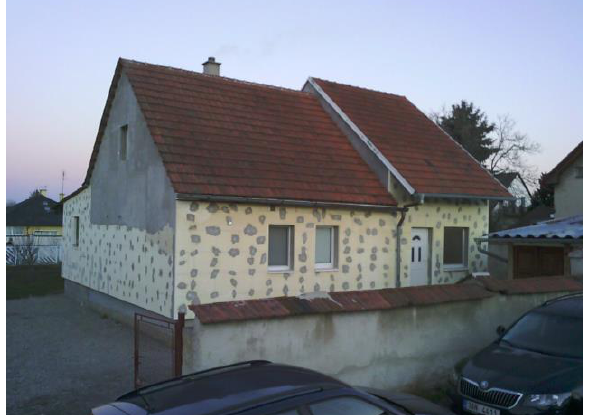
Figure 2. Test object.